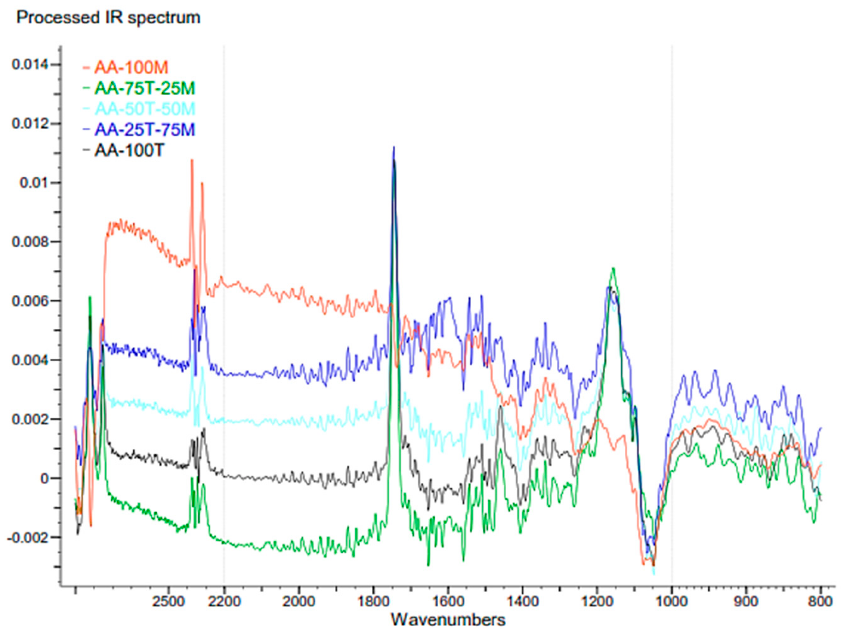
Figure 2. FTIR wave result of the compounds AA-100M; AA-75T-25; AA-50T-50M; AA-25T-75M; AA-100T.